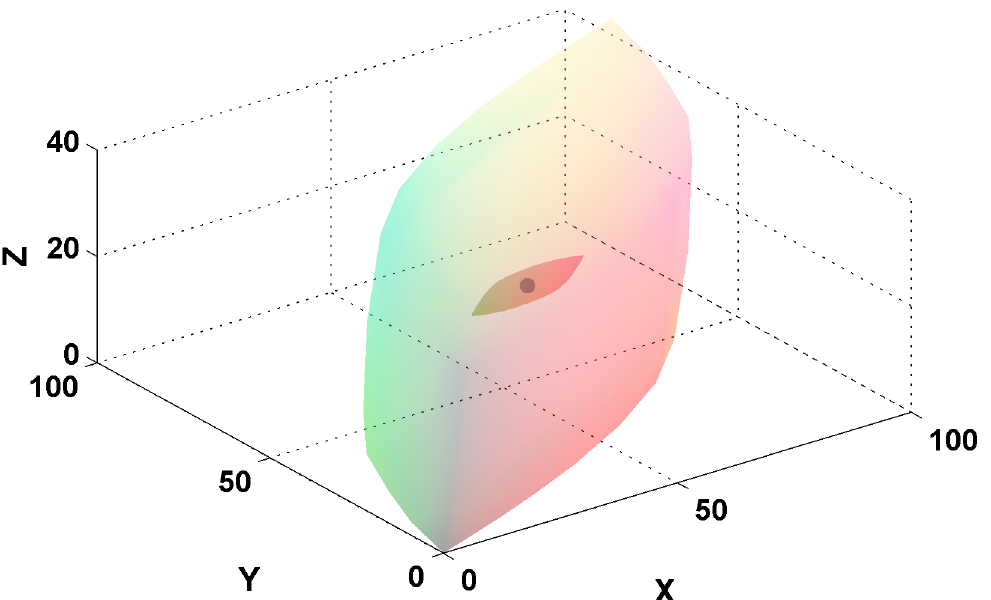
Fig 1. Metamer mismatch volume for the flat grey spectral reflectance function (see text) when the illuminant changes from CIE D65 to CIE A is shown inside the object-colour solid for CIE A. The coordinates are XYZ in the CIE 1931 colorimetric space. The grey dot indicates the location of the colour signal corresponding to the flat grey reflectance. It is located at the centre of the object colour solid and lies inside the metamer mismatch